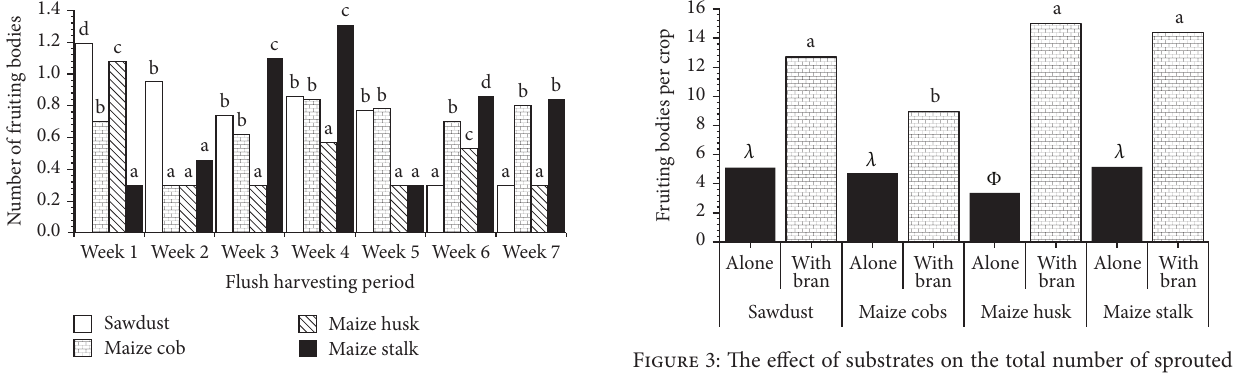
Figure 1: The effect of substrate material on fruiting body sprouts (flushes) over time. (1) Bars with the same Arabic numerals during a harvesting period are not significantly different 𝑃 < 0.001 . (2) 50 g of mushroom spawn was mixed with 1kg substrate and incubated at 26–28 ∘ C for about 20–34 days. (3) The mushroom flushes were recorded over six weeks.